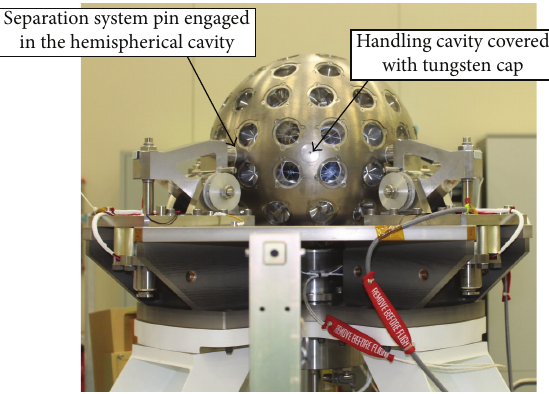
Figure3:MicrographofthetungstenalloyusedforLARES.Average grain dimension 50 𝜇 m.